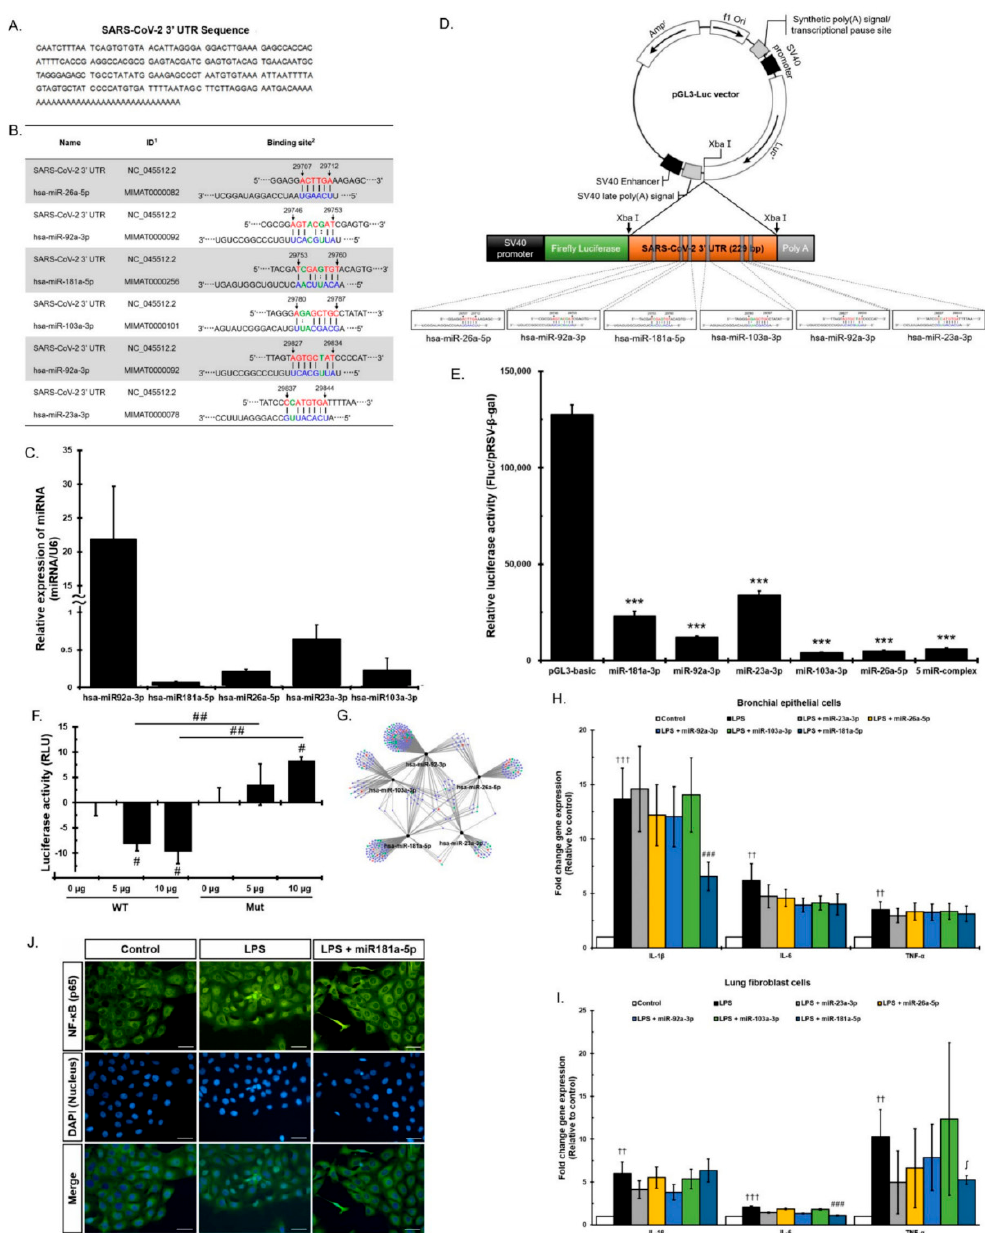
Figure 3. Direct viral effect of miRNAs in EVs on SARS-CoV-2. ( A ) The 3 (cid:48) UTR sequence of SARS-CoV-2. The sequence was obtained from the NCBI database (accession NC_045512.2). ( B ) SARS-CoV-2 3 (cid:48) UTR binding sites of five miRNAs. Each number indicates the following: 1. Accession ID of NCBI or miRBase; 2. The interaction diagram of binding site in 3 (cid:48) UTR of SARS-CoV-2. A line means a perfect match, and a dot line means G:U wobble pairs. An empty space in seed regions means mismatch. ( C ) Confirmation of expression of five miRNAs measured by qPCR. ( D ) Schematic representation of the luciferase constructs used for the reporter assays. Specifically, the pGL3 SARS-CoV-2 3 (cid:48) UTR construct was transfected into human neuroblastoma SK-N-BE(2)C cells. Co-transfection of these cells with miR-92a-3p, miR-26a-5p, miR-23a-3p, miR-103a-3p, miR-181a-5p, or all five miRNAs together, reduced luciferase activity. ( E ) The SARS-CoV-2 3 (cid:48) UTR is a putative target of the five miRNAs identified in this study. The luciferase reporter assay revealed that miR-92a-3p, miR-26a-5p, miR-23a-3p, miR-103a-3p, and miR-181a-5p are potential regulators of SARS-CoV-2. ( F ) Either wild (WT) or mutant (Mut) forms of SARS-CoV-2 3 (cid:48) UTR reporter vector were transfected to the SK-N-BE(2)C cells followed by pMSC-EVs (0, 5, 10 µ g) treatment. Each group of luciferase activity is presented as percentages of difference to each mean of baseline (WT 0 µ g and Mut 0 µ g). ( G ) Enrichment analysis of biological processes targeted by the five miRNAs in EVs. The blue circle represents genes related to transcription, the green circle indicates immune regulation function, and the red circle shows genes with dual functions of transcription and immune regulation. ( H ) Expression of IL-1 β , IL-6, and TNF- α . Bronchial epithelial cells were treated with each miRNA, followed by LPS. ( I ) Expression of IL-1 β , IL-6, and TNF-